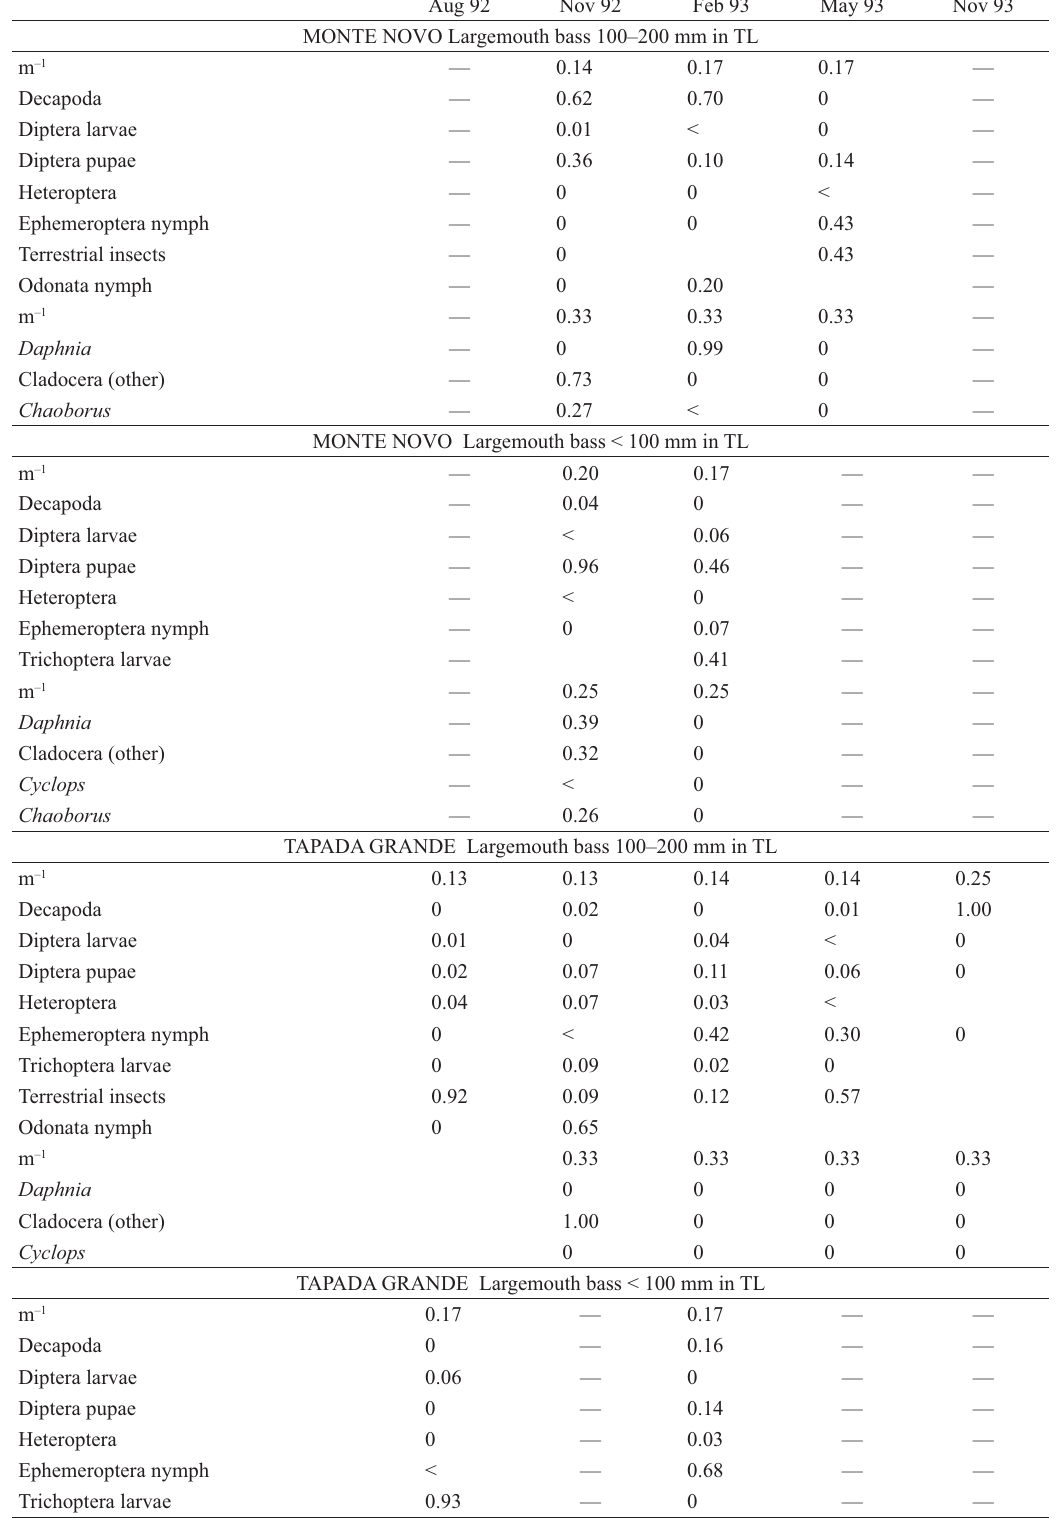
Manly–Chesson (a) for size-classes of largemouth bass, Micropterus salmoides , feeding on